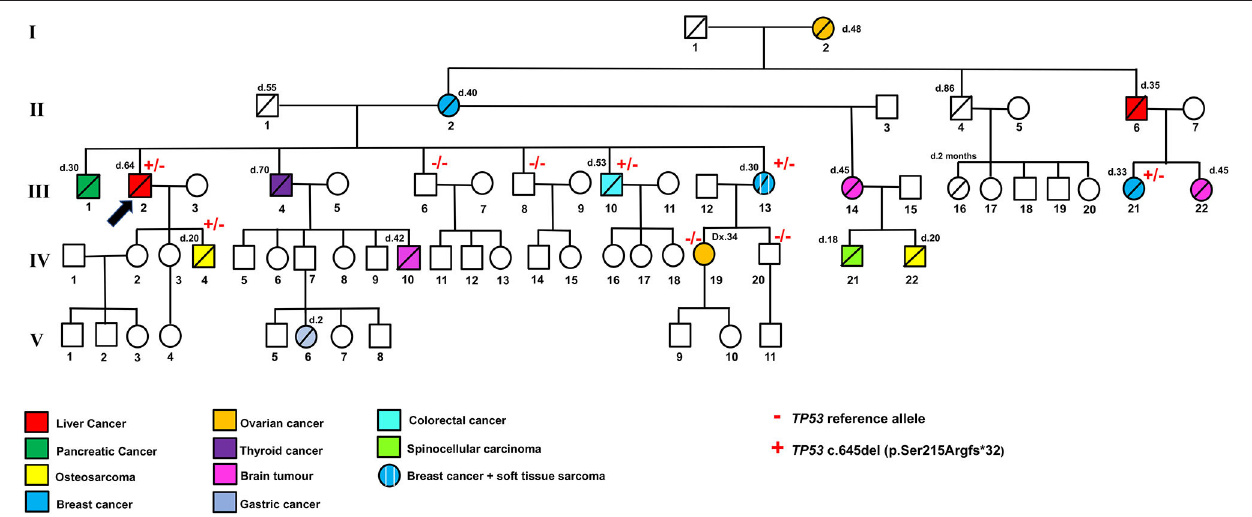
FIGURE 1 | Family pedigree indicating the genotype and phenotype of each individual. + and – indicate the TP53 pathogenic variant c.645del (p.Ser215Argfs*32) and TP53 reference allele, respectively. Different colors indicate liver cancers, pancreatic cancer, osteosarcoma, breast cancer, ovarian cancer, thyroid cancer, brain tumor, gastric cancer, colorectal cancer, spinocellular carcinoma, and soft tissue sarcoma. d, age of death; Dx, age of